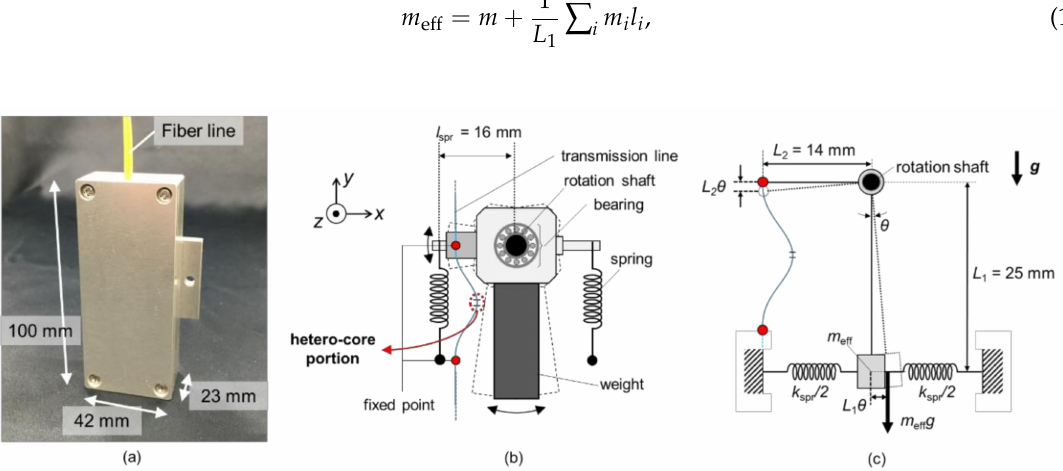
Figure 2. ( a ) Photo of outside appearance; ( b ) internal structure; and ( c ) schematics of a pendulum-type accelerometer with a hetero-core fiber optic